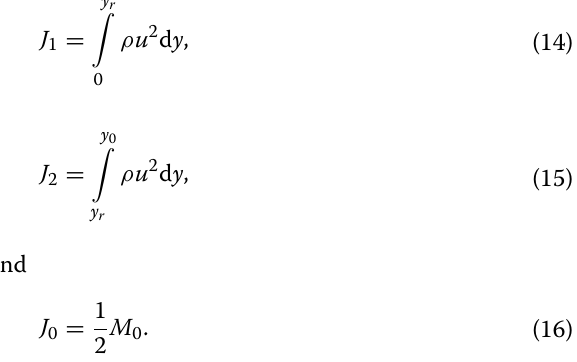
Figure 3 First jet’s velocity distribution at the inlet